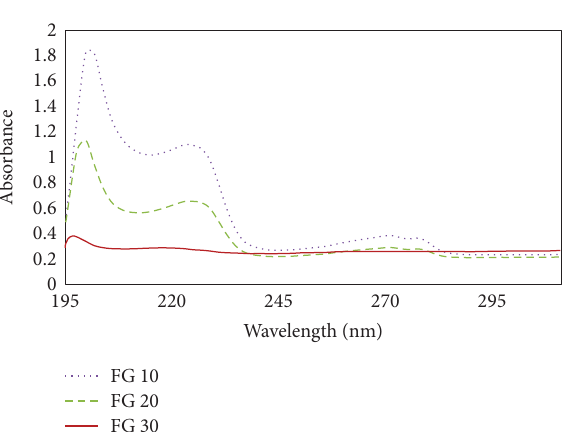
Figure 3: UV-vis absorption spectra of FG 10, FG 20, and FG 30.